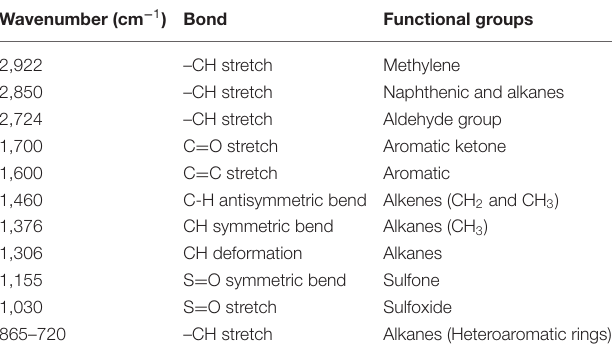
TABLE 8 | Infrared spectral absorption peaks of base asphalt.